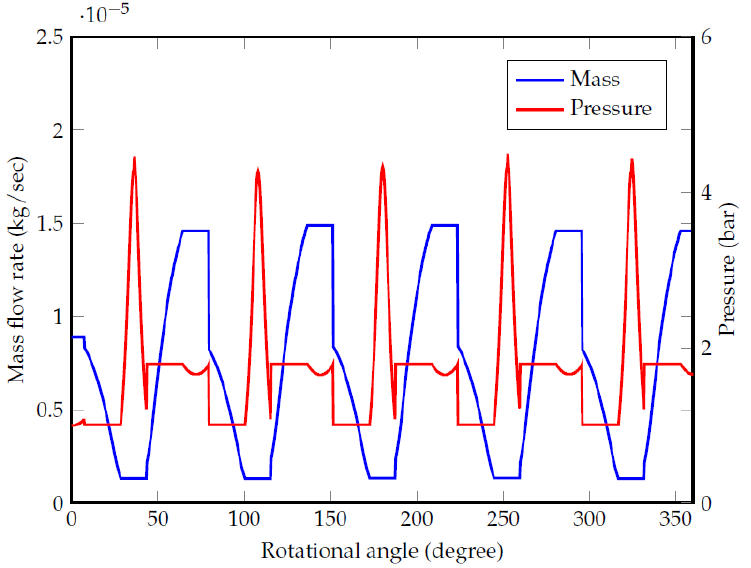
Figure 13. Single cylinder mass and pressure behaviour as a function of the rotational angle.